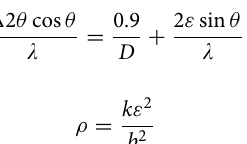
sional microstrip detector made by DECTRIS) arranged in a line. The length of the sensor was about 400 mm and the width of array was 0.05 mm. The distance between the specimen and the detector was 733.96 mm, so that the range and step of diffraction angle of X-ray diffraction profile we measured was about 30 degrees and 0.004 degrees, respectively. The position of the detector was adjusted by the detector arm of the multi-axis diffractom- eter so that the profiles of X-ray diffraction in the range from 9.8° to 40.3° could be measured. The measurement time for each X-ray diffraction profile was 0.2 s 67 . Obtained diffraction peaks were analyzed using the pseudo- Voigt function 68 and values of the full width at half maximum (FWHM) were obtained. The obtained data were analyzed by the Williamson-Hall method 69 to evaluate dislocation densities ρ :